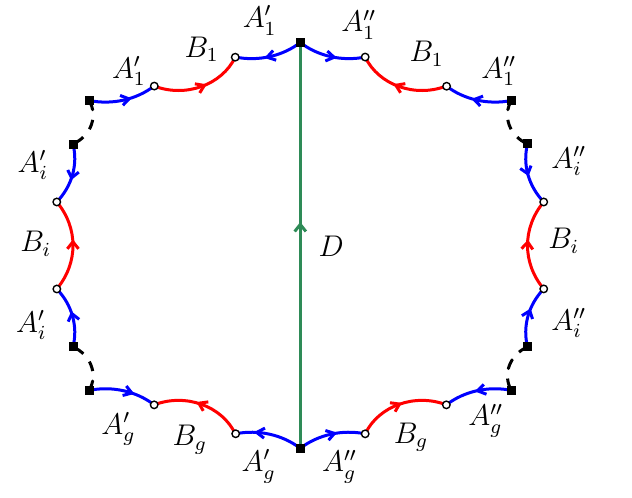
Figure 7. Cut genus g